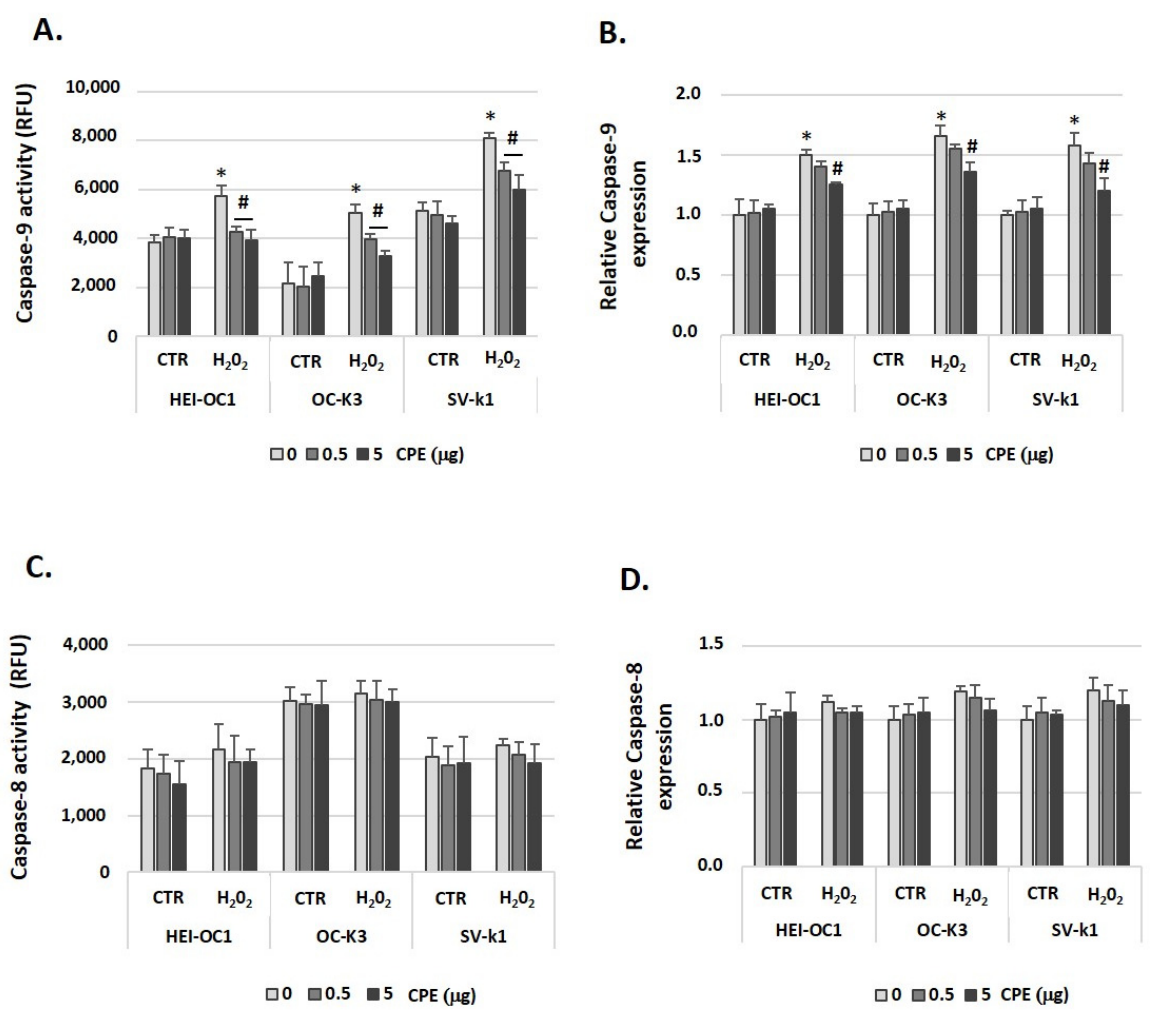
Figure 11. Cocoa treatment impaired mitochondrial cell death pathway in senescence auditory cells. ( A ) Caspase-9 and ( C ) Caspase-8 activity were measured by a fluorescent assay in HEI-OC1, OC-k3, and SV-k1 cell cultures post-treatments. Gene expression of Caspase-9 ( B ) and Caspase-8 ( D ) in auditory cell cultures post-treatments. Experimental groups: CTR group (0; 0.5 and 5 μ g/mL of CPE) and H 2 O 2 group (induced cellular senescence with 100 μ M for 1 h in all groups: 0; 0.5 and 5 μ g/mL of CPE). The diagrams include the mean ± SD Fold change and Relative Fluorescence Units (RFU) in triplicate. * p < 0.05 vs. CTR group; # p < 0.05 vs. H 2 O 2 group ( n = 4). Reference genes: β -actin and GAPDH.